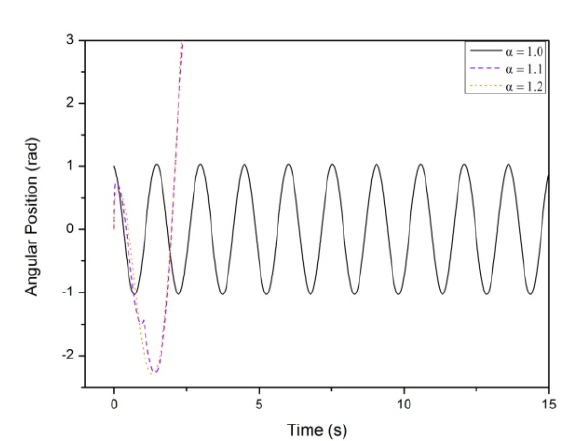
Figure 2. Time history (values of α ≥ 1).